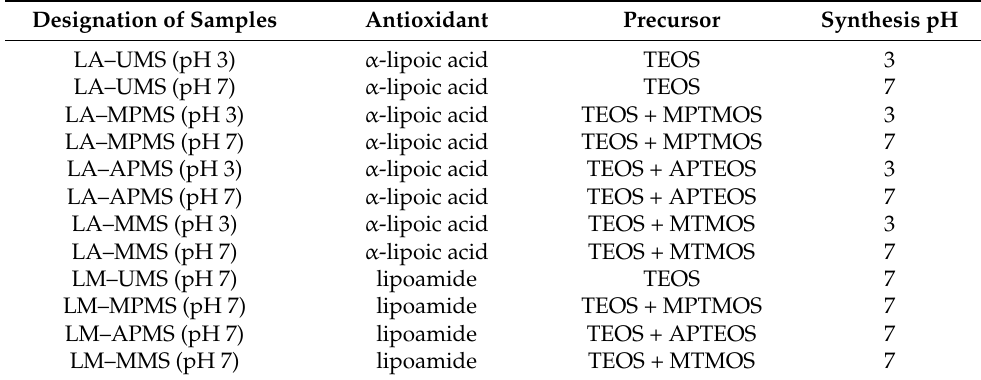
Table 1. Designation of the synthesized composites and conditions of their